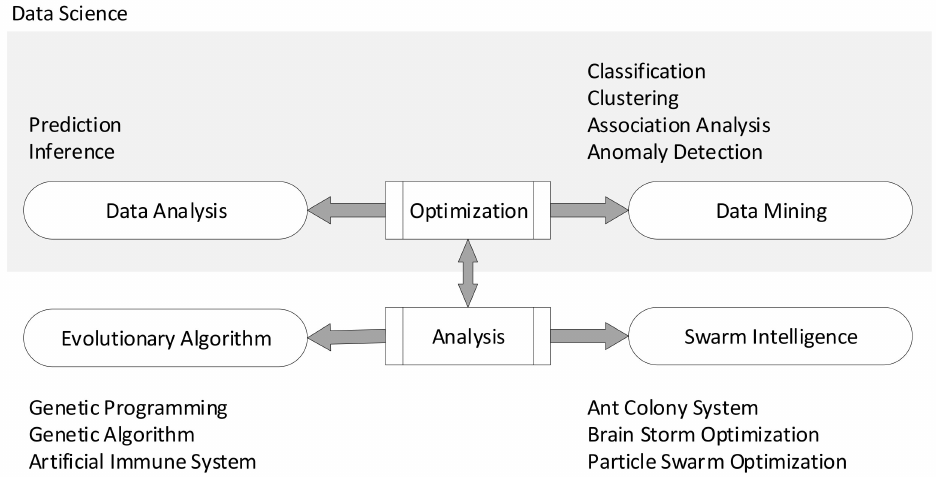
Figure 3. Relationship between data science with evolutionary algorithm and swarm intelligence